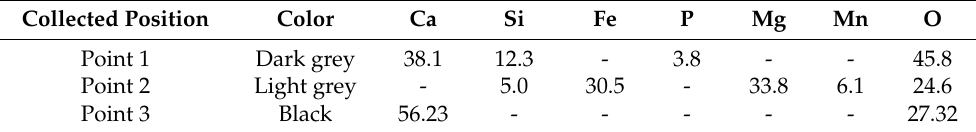
Table 6. EDS analysis results (wt.%) of dephosphorization slag in Heat 3 corresponding to Figure 9.